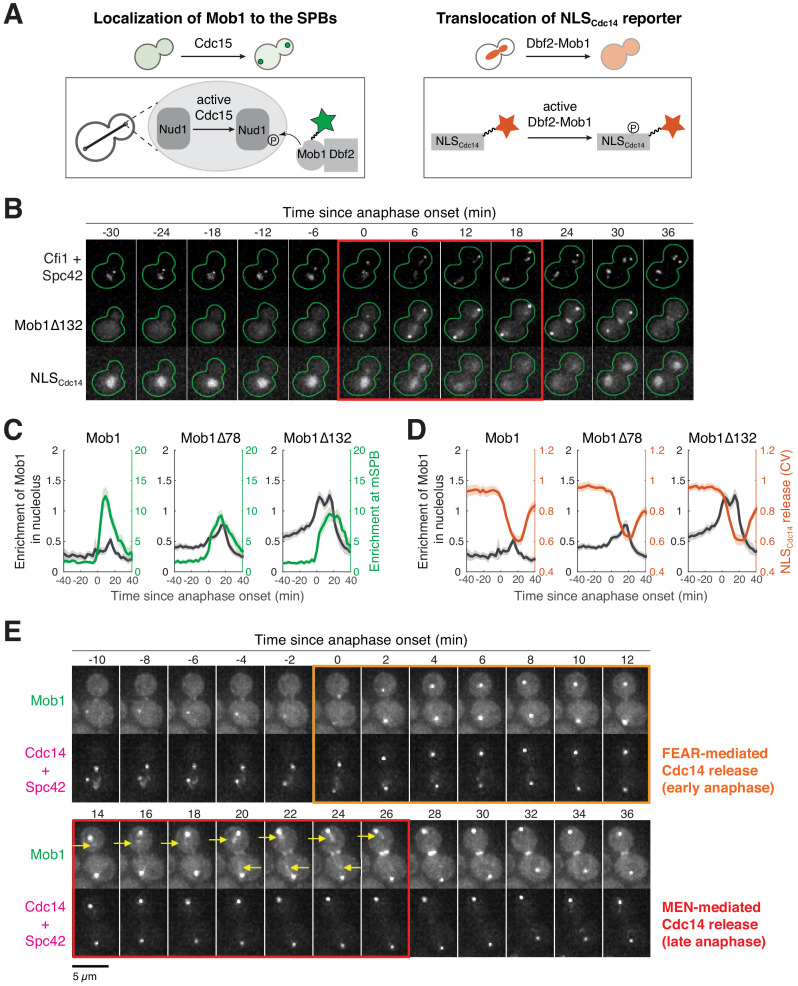
Mob1’s nucleolar localization correlates with mitotic exit network (MEN) activation and Cdc14 release from the nucleolus.(A) Illustration of Mob1’s spindle pole body (SPB) localization and translocation of NLSCdc14 reporter in response to MEN activation. (B) Localization of Mob1Δ132 and the MEN activity reporter NLSCdc14 during the cell cycle. A41213 (GFP-MOB1Δ132, CFI1/NET1-mCherry, SPC42-mCherry, and NLSCdc14-ymiRFP670) cells were grown as in Figure 1E. Red square indicates anaphase. (C) Relative timing of nucleolar localization of Mob1 (black) and SPB localization of Mob1 (green) in cells harboring the indicated MOB1 alleles. (D) Relative timing of nucleolar localization of Mob1 (black) and release of the NLSCdc14 reporter from the nucleus (red) in cells harboring the indicated MOB1 alleles. (E) Localization of Mob1 and Cdc14 during the cell cycle. A40314 (MOB1-eGFP, SPC42-mCherry, and CDC14-mCherry) cells were grown at room temperature in SC medium + 2% glucose and imaged every 2 min for 4 hr. The colored squares indicate the frames where Cdc14 is released from the nucleolus mediated by either the Cdc fourteen early anaphase release (FEAR) network or the MEN. Yellow arrows highlight localization of Mob1 in the nucleolus.